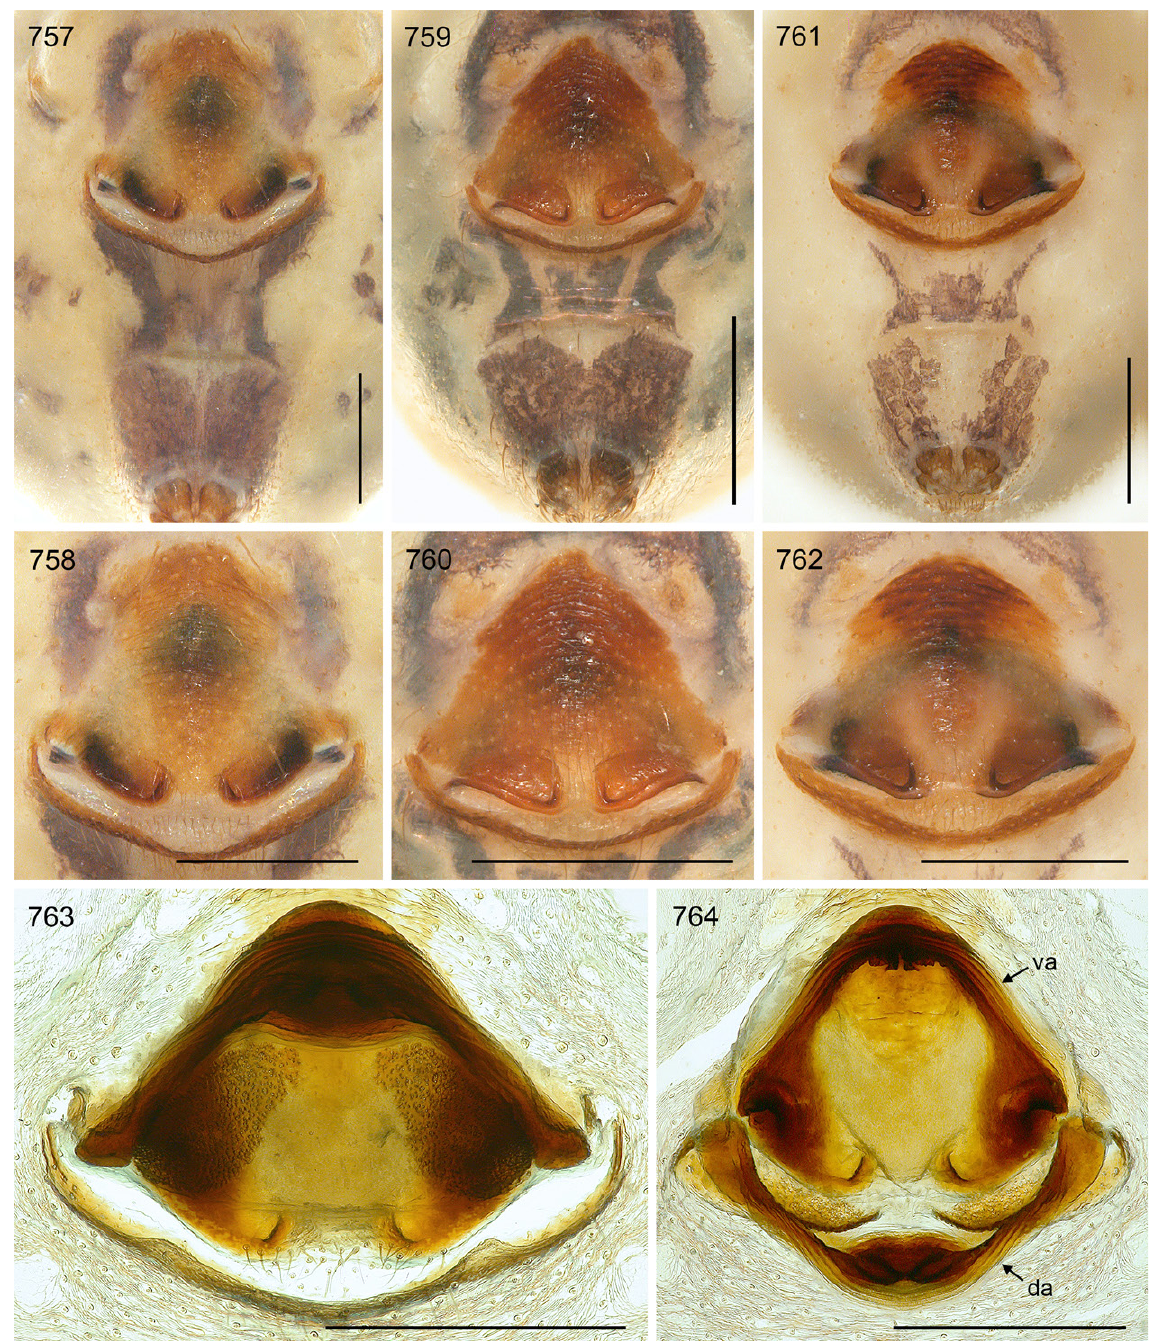
Figs 757–764. Crossopriza srinagar sp. nov. 757–758 . Female from India, Srinagar (ZFMK Ar 22450), abdomen and epigynum, ventral views. 759–760 . Female from Pakistan, “N env. of Islamabad, National Park” (ZMMU), abdomen and epigynum, ventral views. 761–762 . Female from Pakistan, 7 km NE Gobor-o-Bakh (ZMMU), abdomen and epigynum, ventral views. 763–764 . Female from India, Srinagar (ZFMK Ar 22450), cleared female genitalia, regular dorsal view and dorsal view with dorsal arc tilted backwards. Abbreviations: da = dorsal arc; va = ventral arc. Scale bars = 0.5